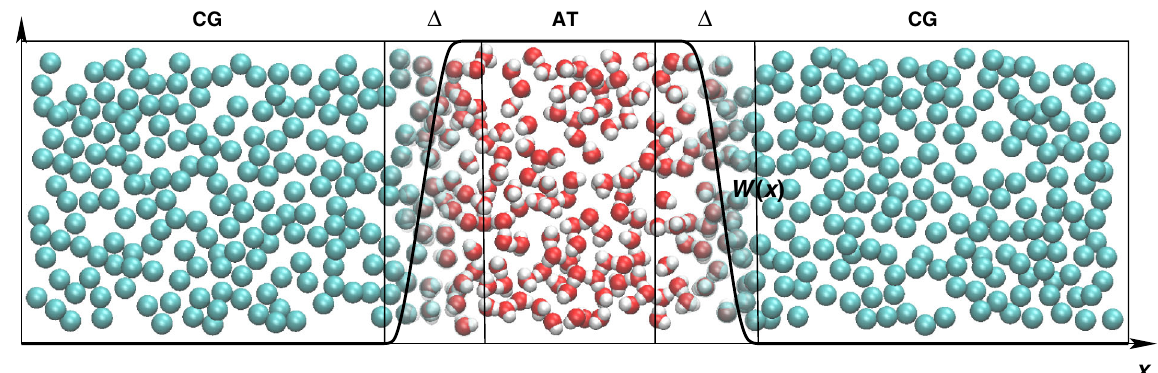
FIG. 1. A schematic representationof liquidwater inAdResS. CG indicatesthe region at coarse-grained resolution,AT thatat atomistic resolution, and finally (cid:1) the transition region where molecules change resolution according to a smooth switching function w ð x Þ